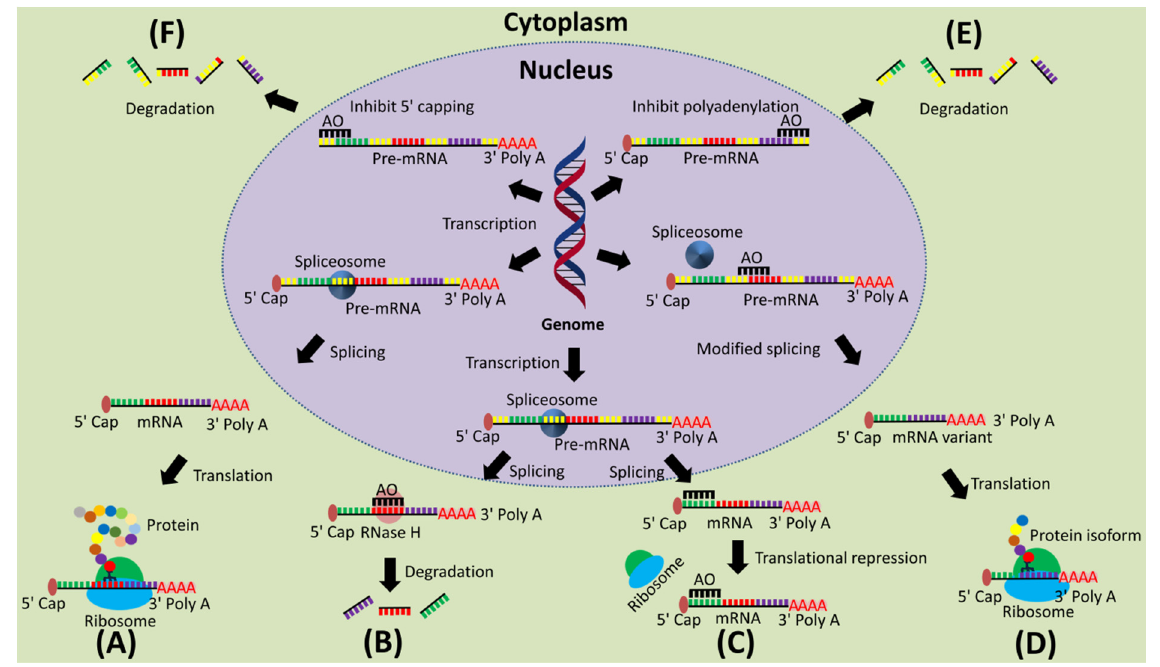
Figure 2. Mechanism of action of AOs to alter gene expression. ( A ) Normal gene expression process; ( B ) AO-induced RNase H-mediated mRNA degradation; ( C ) AO-induced translational repression; ( D ) AO-induced splice modulation; ( E ) AO-induced inhibition of polyadenylation; ( F ) AO-induced inhibition of 5 ′ capping.